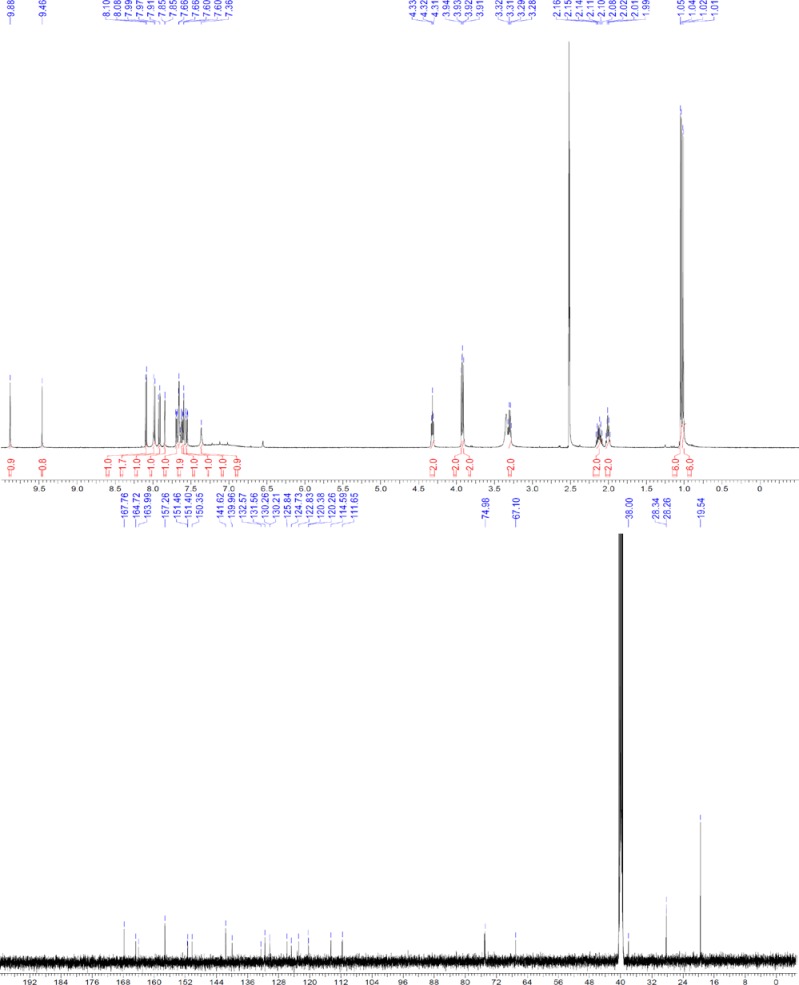
1H and 13C NMR of ERX-12.